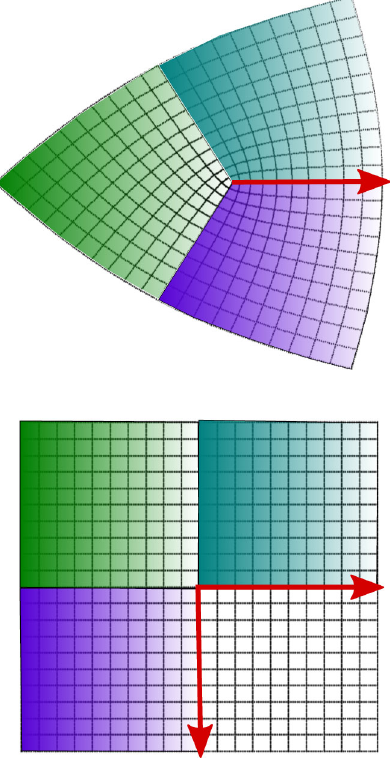
FIG. 3. A 90-degree disclination maps discontinuously to the square lattice, as indicated with the colored quadrants. The red line is the branch cut across which the image rotates by 90 degrees. Because the discontinuity is by a rotation in G , this map descends to a continuous map from the disclination to the quotient of the square lattice by G .